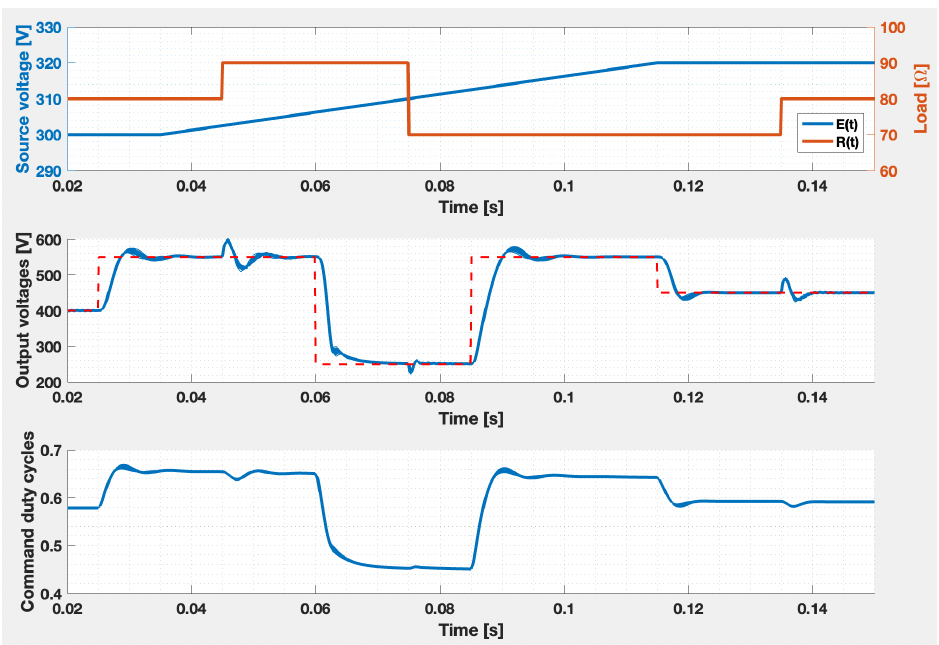
Figure 4. The averaged bilinear model of the DC-DC SEPIC converter for both nominal plants, along with 30 Monte Carlo simulations according to Figure 1 and using the sub-optimal parameters = 8.9189 × 10 4 of the K-PBC; the first plot—the exogenous inputs, the α (cid:63) = 1 × 10 − 3 and K (cid:63) 2 second plot—the reference signal (dotted red) and the output voltage (blue), and the third plot—the command